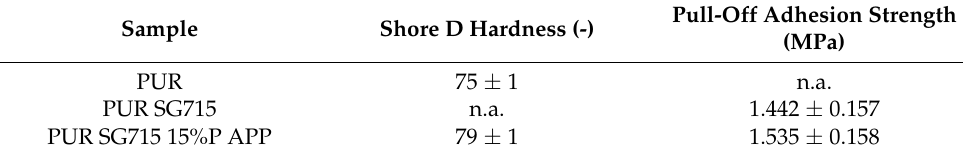
Figure 5. The heat release rate ( a ) and the mass loss ( b ) of reference and coated PUR samples. Table 4. Shore D hardness and the pull-off adhesion strength PUR